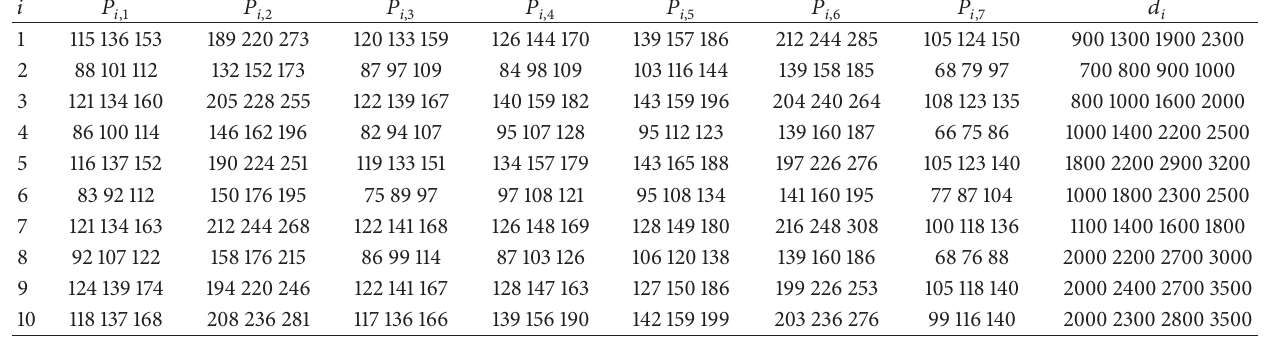
Table 8: Fuzzy processing time and fuzzy due date of the 10 × 7 fuzzy FSSP.